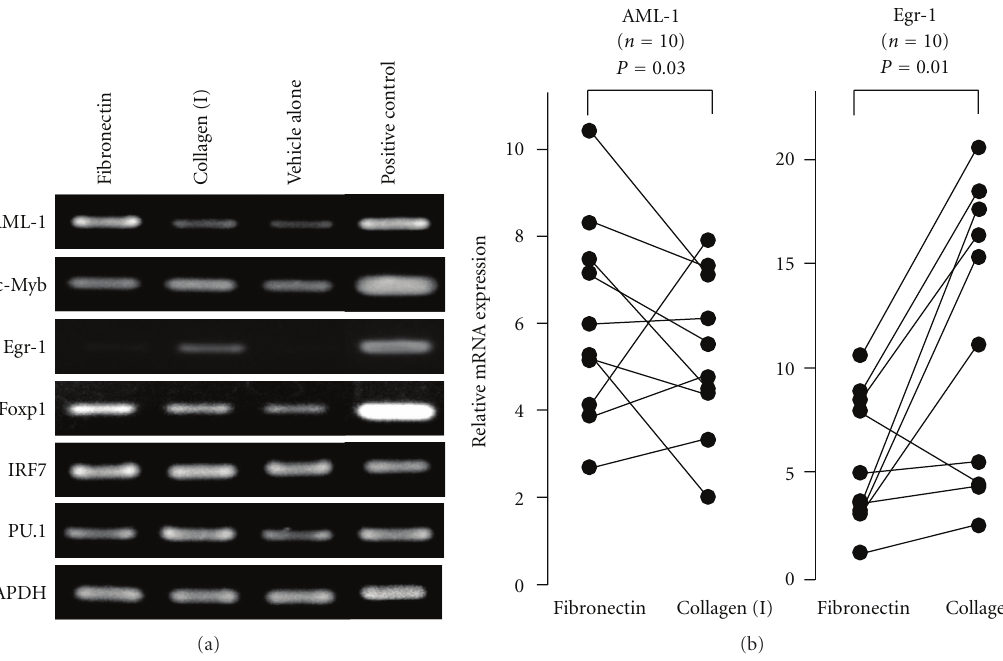
Figure 3: Expression profiles of transcription factors in monocytes exposed to fibronectin or collagen (I) for 24 hours. (a) MACS-sorted CD14 + monocytes (4 × 10 5 ) were cultured with CD14 − PBMC-conditioned medium on 24-well plastic plates coated with fibronectin (Sigma), collagen (I), or vehicle alone for 24 hours. Then, adherent cells were recovered and subjected to reverse transcription and semi- quantitative PCR for evaluation of mRNA expression. Positive controls for the specific amplification included cultured skin fibroblasts for Egr-1, HL-60 for PU . 1, c-Myb, and AML-1, and THP-1 for IRF-7 and Foxp1. The results shown are representative of 5 independent experiments. (b) Quantitative Taqman real-time PCR examining gene expression levels of Egr-1 and AML-1 in adherent cells obtained from cultures of CD14 + monocytes with CD14 − PBMC-conditioned medium for 24 hours on fibronectin (BD Biosciences) or collagen (I). Results obtained from 10 independent healthy donors are shown. Di ff erences in expression levels are tested by paired t